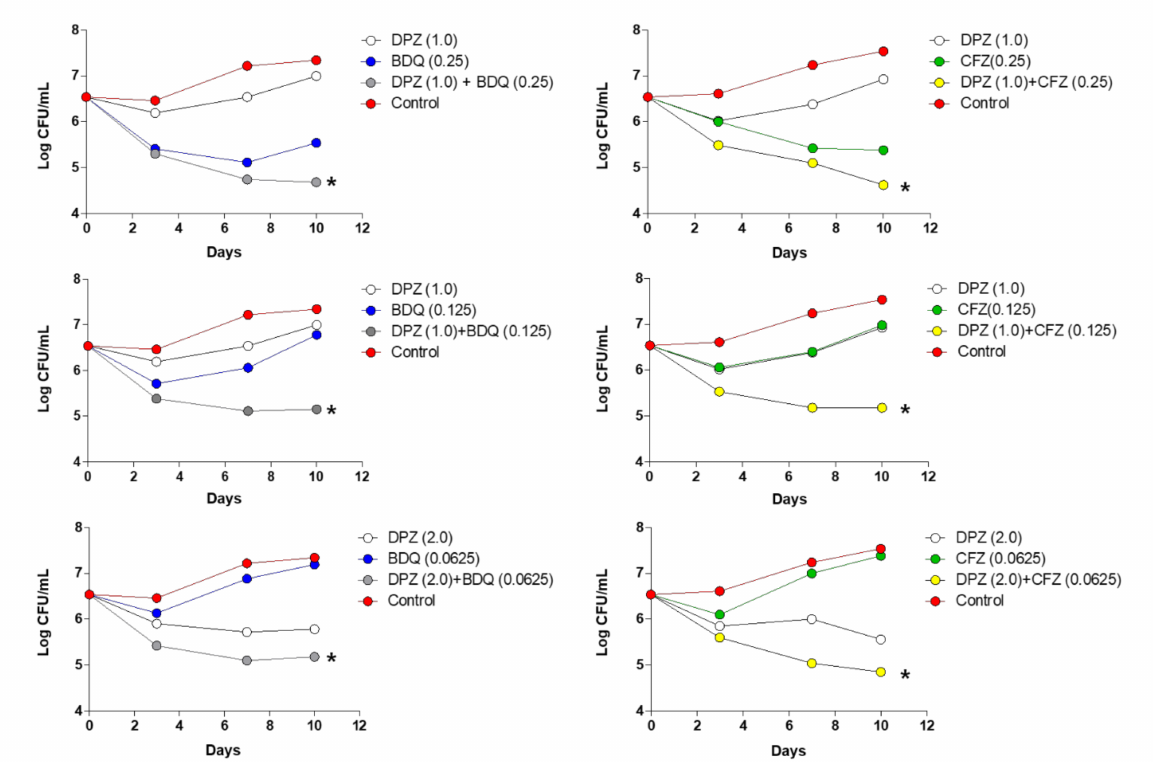
Figure 4. In vitro combination time-kill assay with anti-TB drugs. Viability of M. tuberculosis H37Rv was evaluated using combinations of various concentrations of delpazolid and bedaquiline or clofazimine ( µ g /